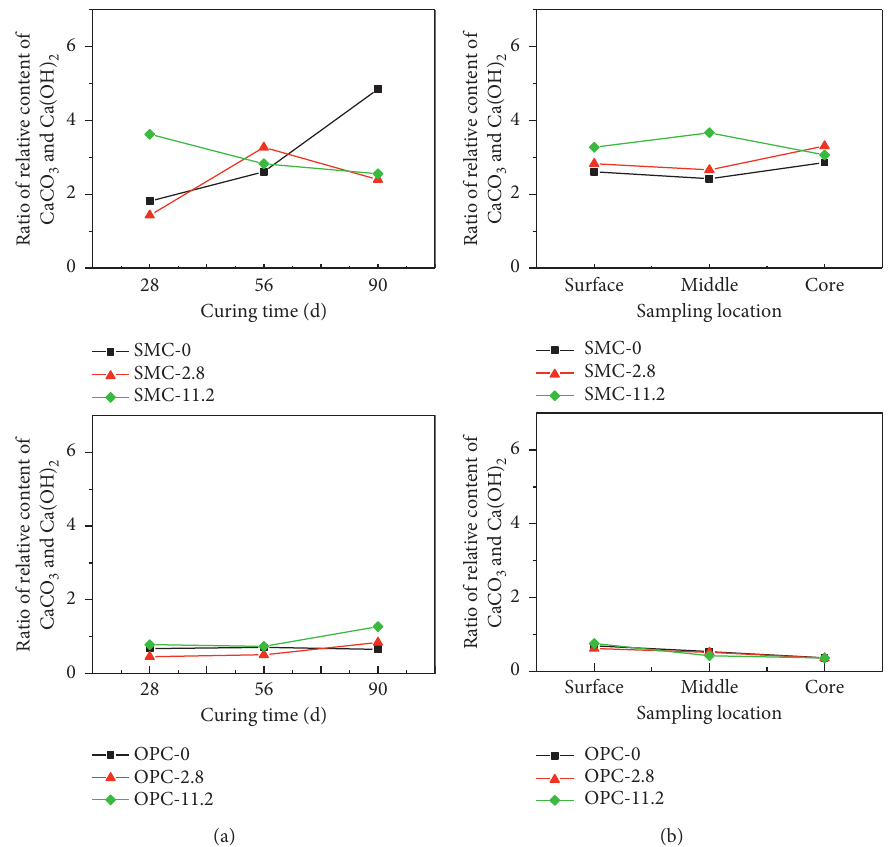
Figure 10: Change in trend of relative mass ratio of calcium carbonate to calcium hydroxide after leaching: (a) different ages and velocities; (b) different sampling depths at 56